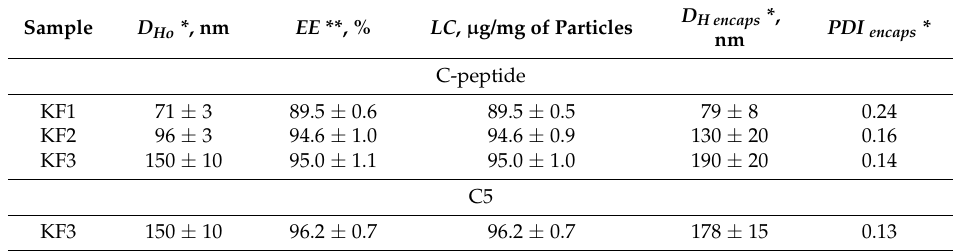
Table 4. Dependence of encapsulation efficiency, loading content and hydrodynamic diameter of nanospheres on polymer composition and peptide.